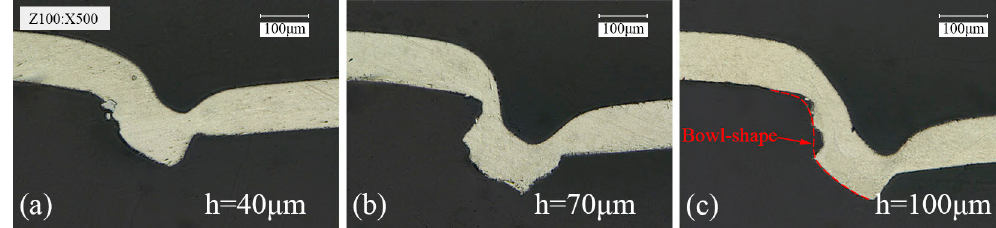
Figure 7. Cross sections of single layer 1060 pure aluminum foil (100 μ m in thickness) produced under different die depth h ( En = 1290 mJ, 3 pulses): ( a ) h = 40 μ m; ( b ) h = 70 μ m; ( c ) h = 100 μ m.